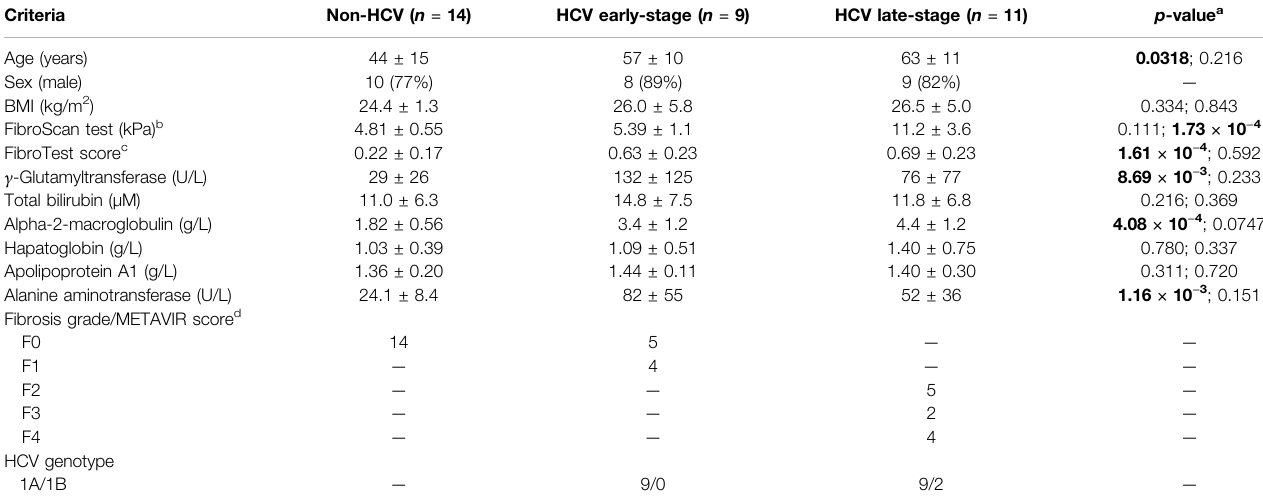
TABLE 1 | Study characteristics of treatment-naïve hepatitis C virus (HCV) infected patients ( n (cid:1) 20) at different stages of liver fi brosis, and healthy non-HCV infected participants ( n (cid:1) 14).